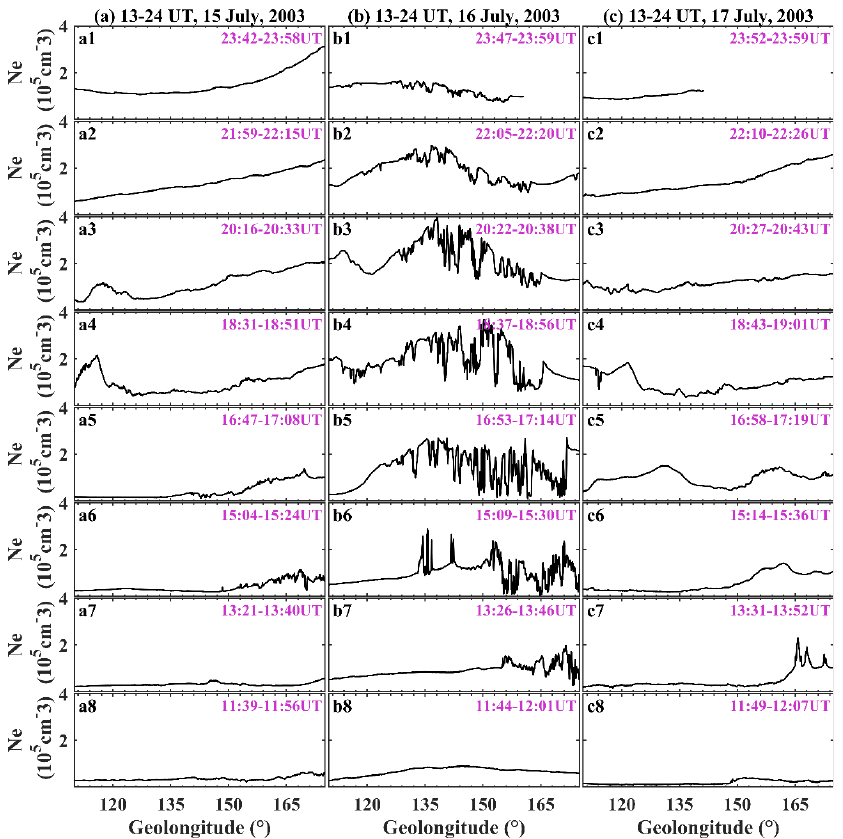
Figure 8. ROCSAT-1 observations of in situ ion density (Ni) variation as a function of geographic longitude over the Eastern Asian sector during 13 – 24 UT on ( a ) 15, ( b ) 16, and ( c ) 17 July 2003. The corresponding labels are the same as those used in Figure 7. Universal time (UT) information is given in the upper right corner of each